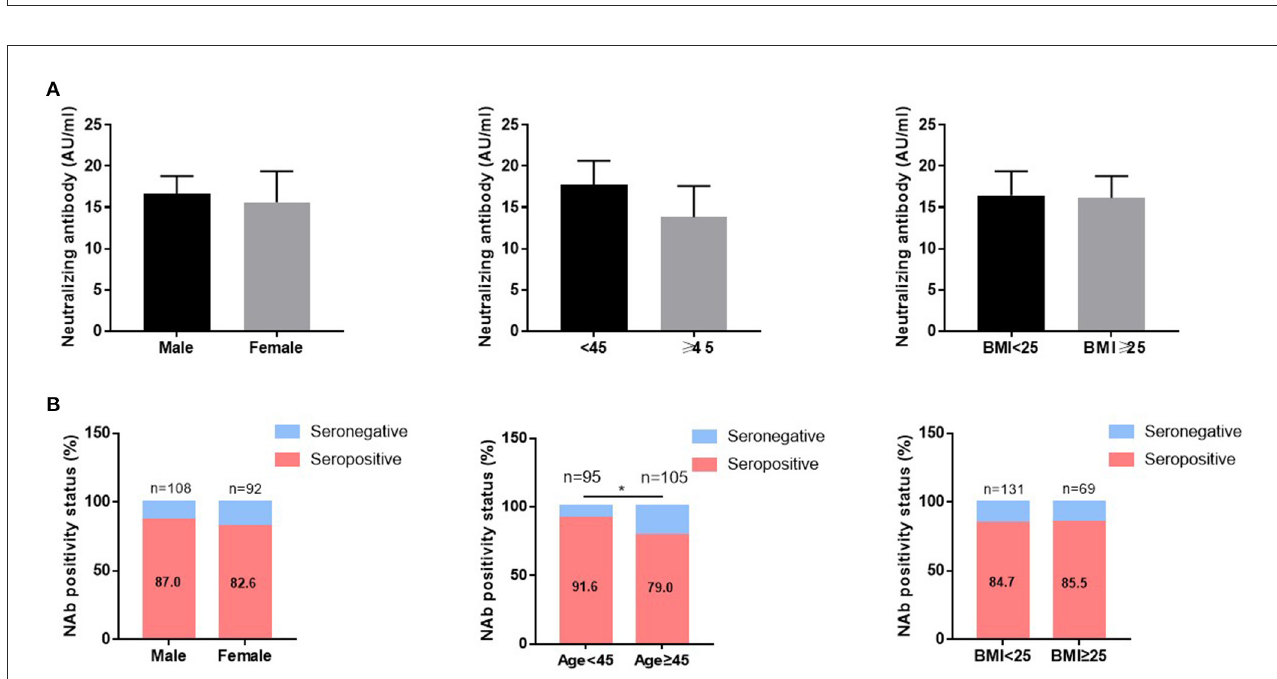
FIGURE2 The influence of age, sex, and BMI on the immunogenicity of vaccines in CHB patients. The neutralizing antibody (NAb) concentrations (A) and NAb positive rates (B) were compared according to sex, age, and BMI in patients with chronic hepatitis B. *** P <